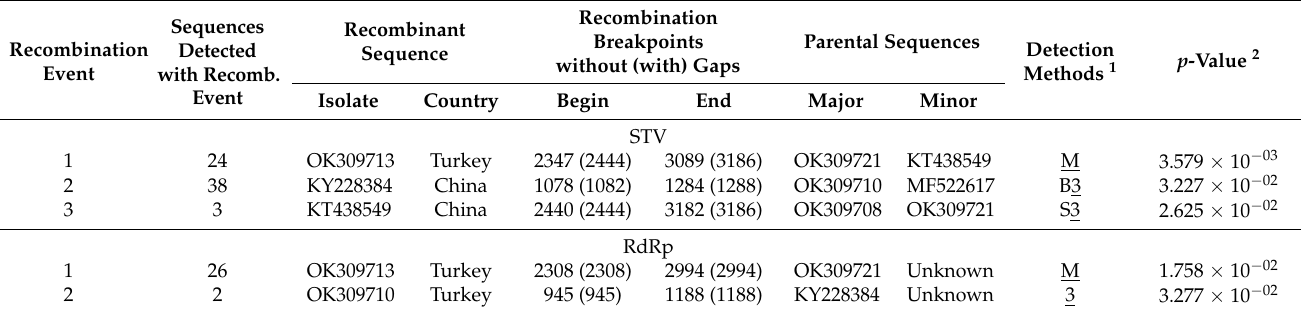
Table 3. Description of recombination events detected using RDP in the full-length genome and RdRp region of globally reported STV populations.